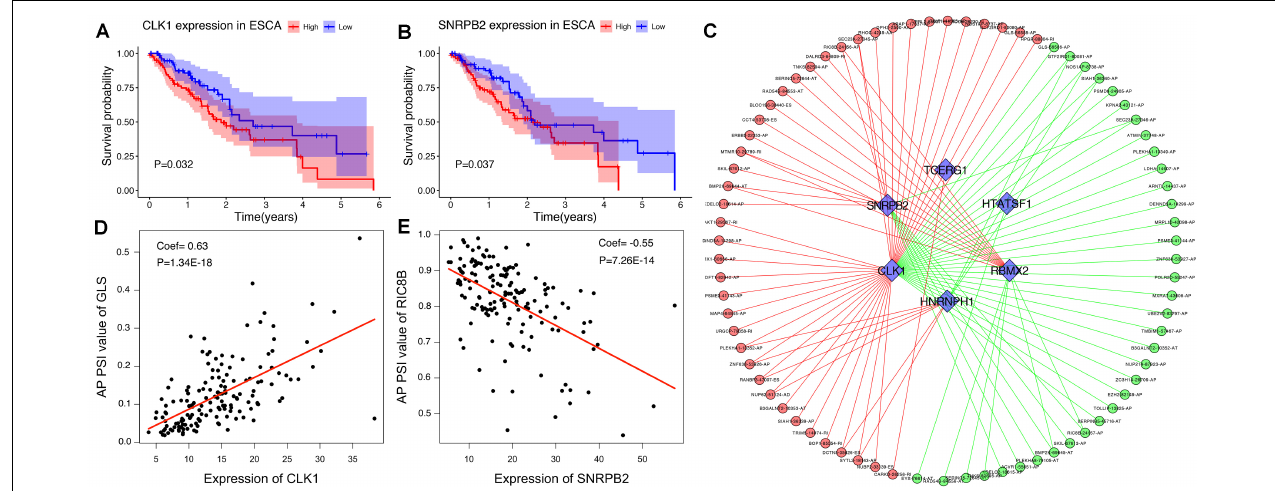
FIGURE 10 | The OS-associated splicing factors in ESCA and SF-AS correlation network. (A,B) Kaplan-Meier curves of survival-related splicing factors. (C) SF-AS correlation network. Blue triangles were OS-associated splicing factors. Red/green lines represent positive/negative correlations between substances. Red/green dots represent adverse/favorable AS events. (D,E) Dot plots of correlations between expression of SFs (CLK1 and SNRPB2) and PSI values of OS-associated AS events.